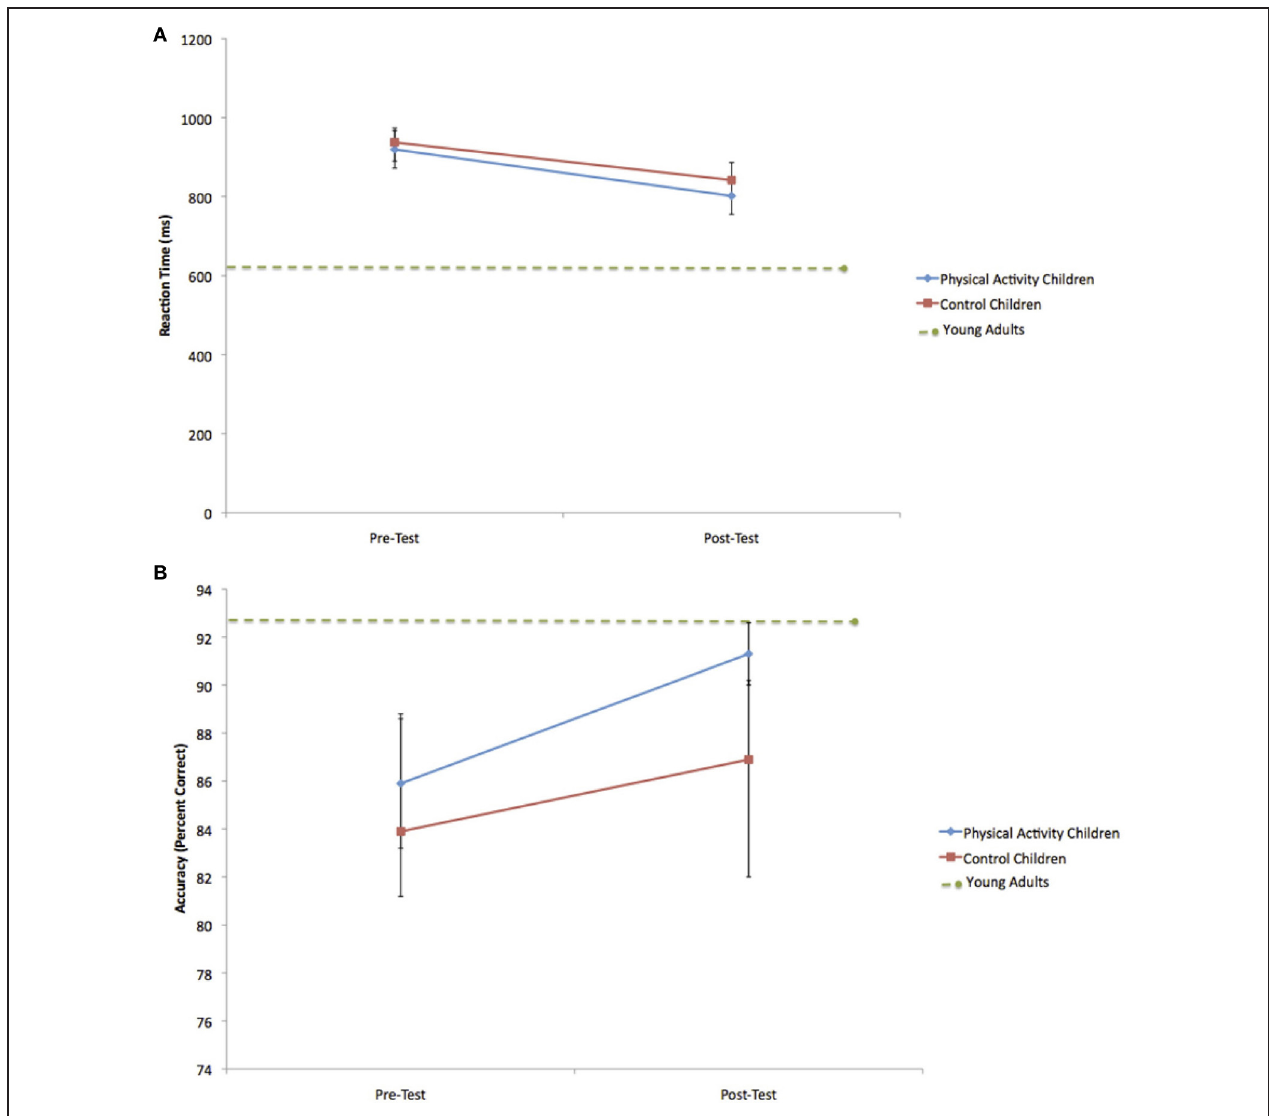
FIGURE 3 | (A) Change in incongruent RT for the physical activity intervention group and wait-list control group. Error bars represent standard error. The child groups showed longer RT at pre-test and post-test compared to young adults. (B) Change in incongruent accuracy